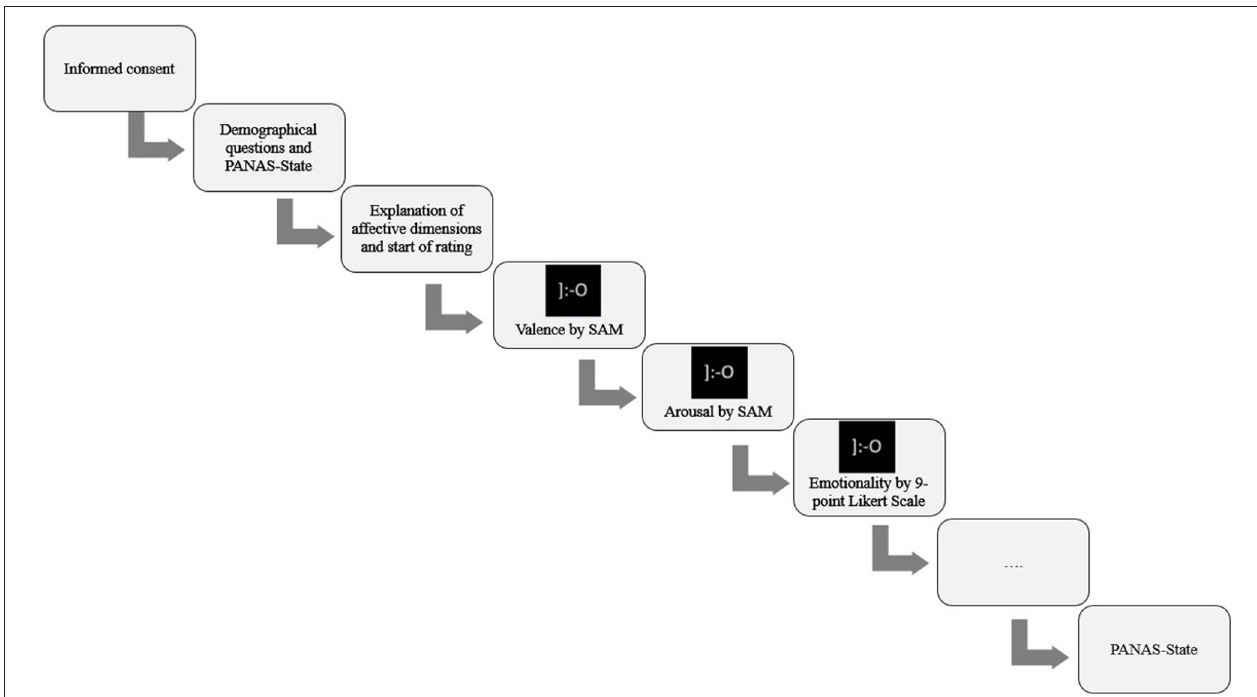
FIGURE 1 | Schematic representation of the experimental